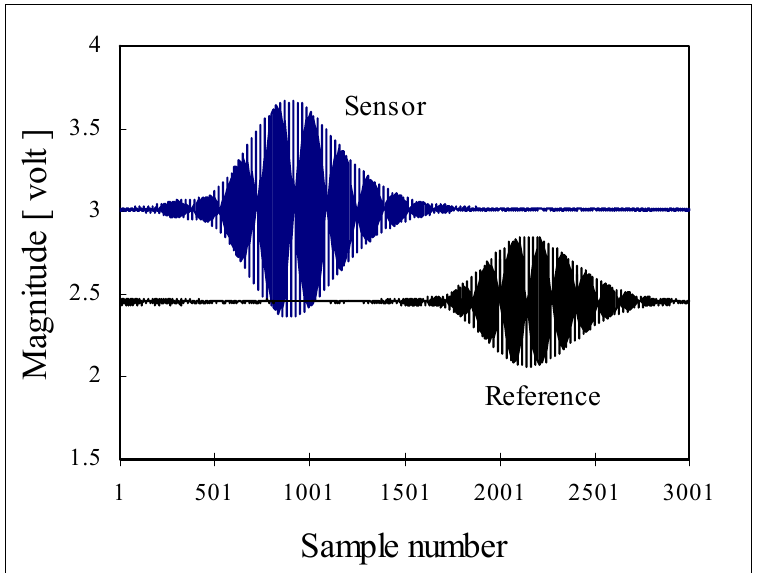
Figure 2b . Typical sensor and reference fringe